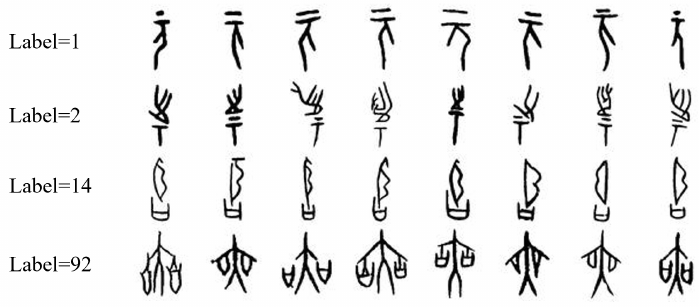
Figure 4. Examples of OBI-100 dataset.